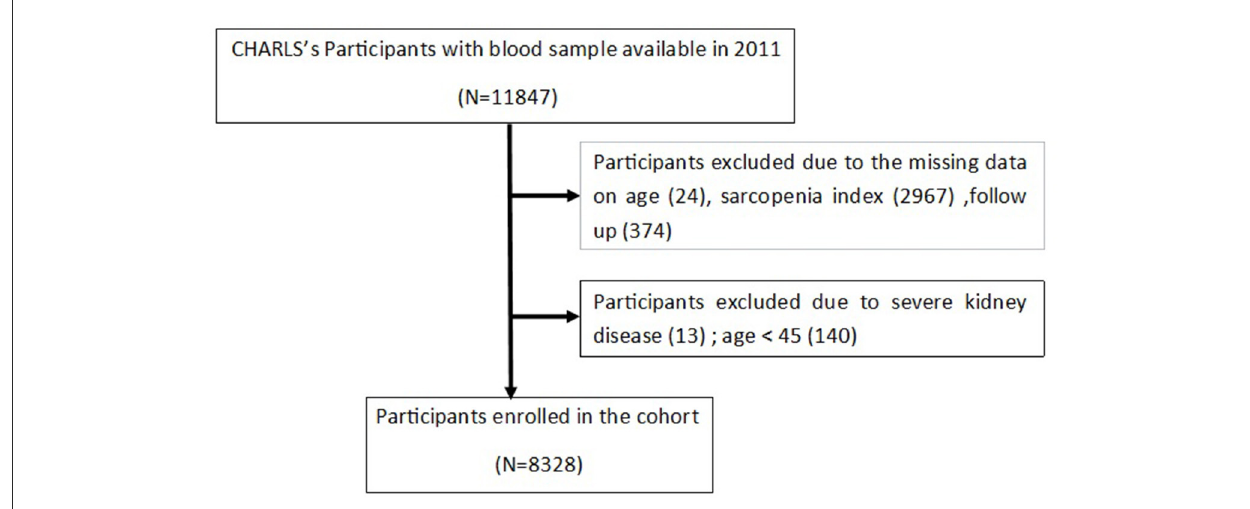
FIGURE1 The flowchart of study participants.